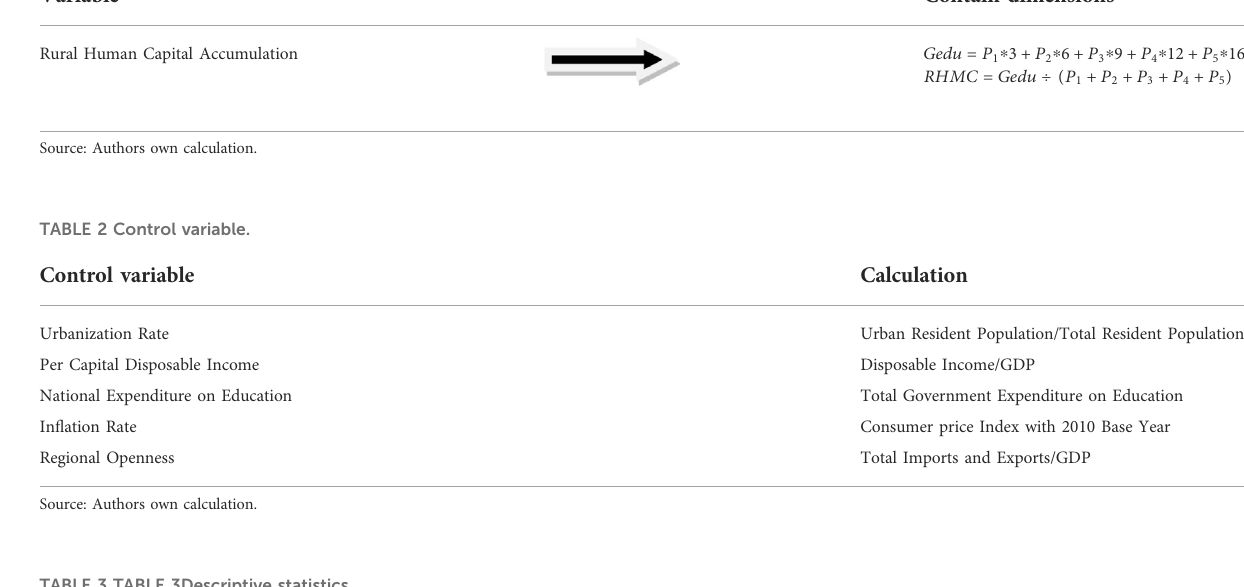
TABLE 3 TABLE 3Descriptive